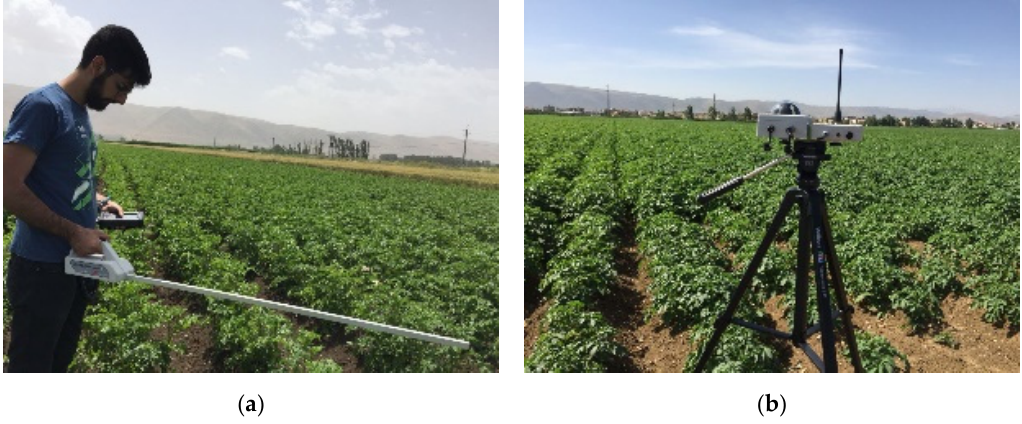
Figure 2 . LAI Measurements: ( a ) Data inputs to the SS1 SunScan Canopy Analysis System, ( b ) beam fraction sensor (BFS) installed in a potato field.